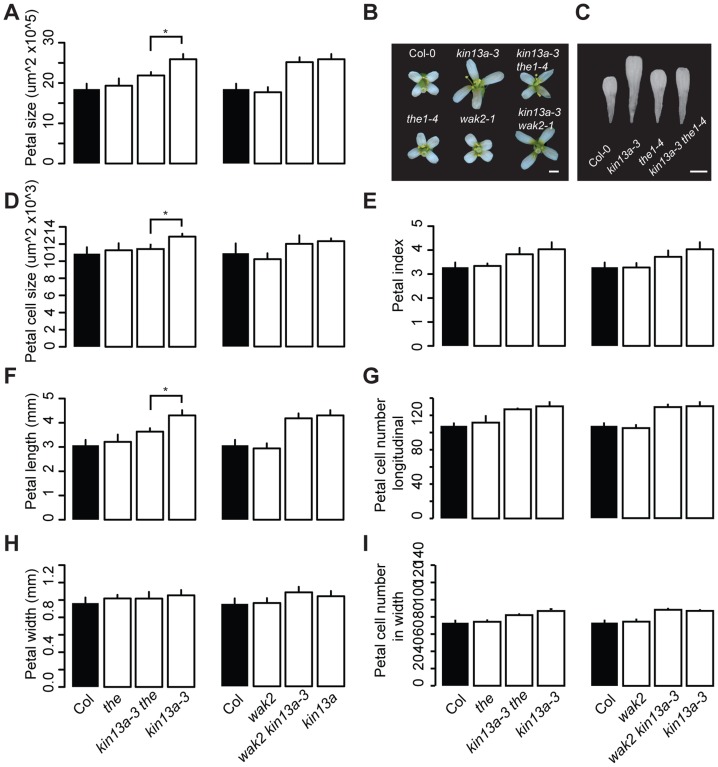
Excess cell expansion in atkin13a mutants requires THE1 activity.(A,D–I) Measurements of petal parameters for the indicated genotypes. (A) Petal size. (B) Whole-flower photographs of the indicated genotypes. (C) Photographs of petals of the indicated genotypes. Scale bars are 1 mm in (B,C). (D) Petal-cell size. (E) Petal index, i.e. length divided by width. (F) Petal length. (G) Petal cell number in the longitudinal direction. (H) Petal width. (I) Petal cell number along the petal width. Values are mean ± SD of more than 12 petals from 8 plants (A,E–I) or of 50 petal cells from more than 8 petals (D). Asterisk indicates significant difference at p<0.05.